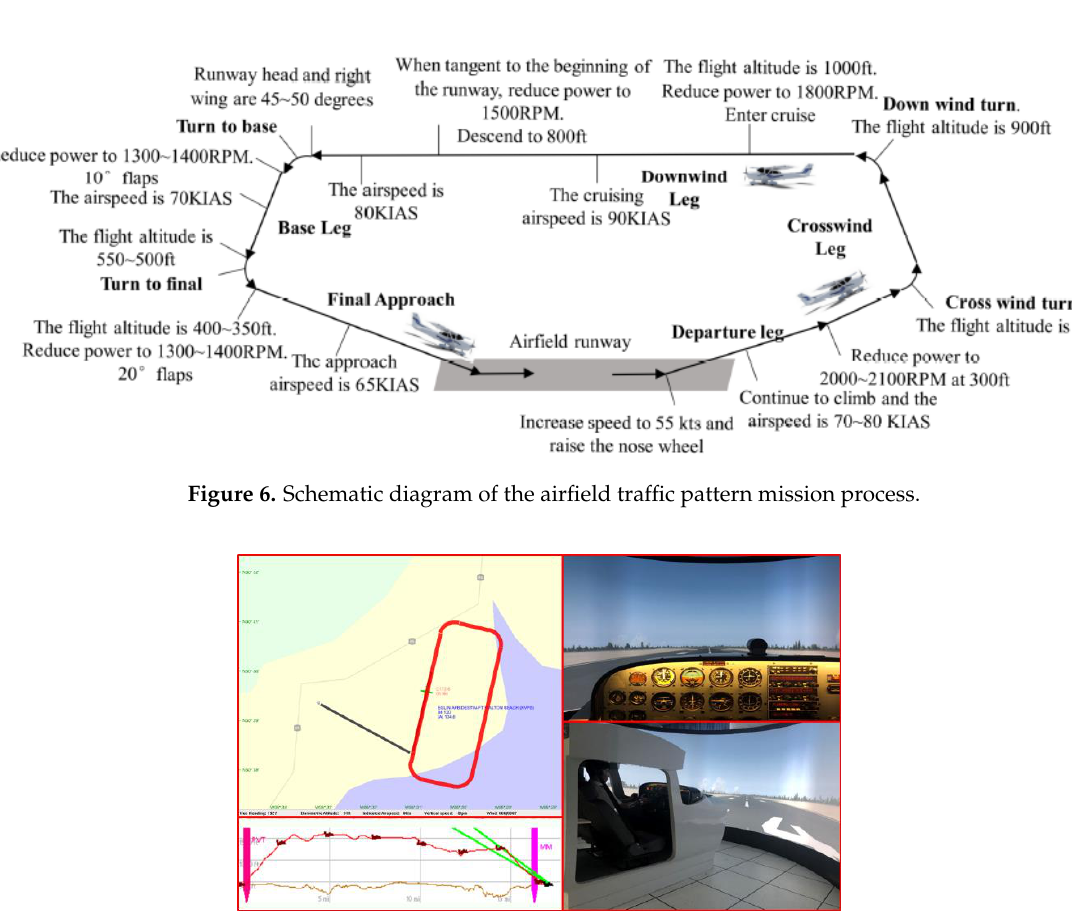
Figure 8. Experimental process. 3.3. Data Collection In this paper, the ECG data of 30 pilots were obtained through flight simulation ex- periments. In order to eliminate the effect of the beginning and the end of the experiment on the pilots ’ psychology, the ECG data from 9:45 to 10:15, 14:45 to 15:15, and 19:45 to 20:15 were selected for analysis. Based on the study of driver fatigue by using a 100s time window of the ECG, the 100 s time window was selected to intercept the ECG data [46]. A total of 1440 effective samples were extracted, and the sample size of each time period